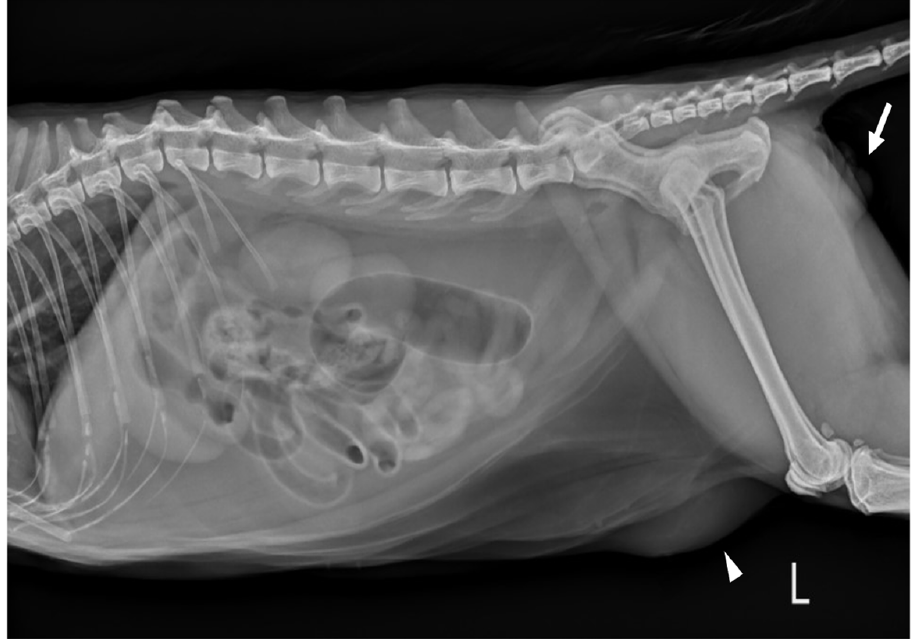
Figure 2. Left lateral abdominal radiograph in a cat revealed edema of the perineal region (white arrows). The cutaneous mass with fat opacity in the inguinal region (white arrowheads) was cytologically suspected as a lipoma.